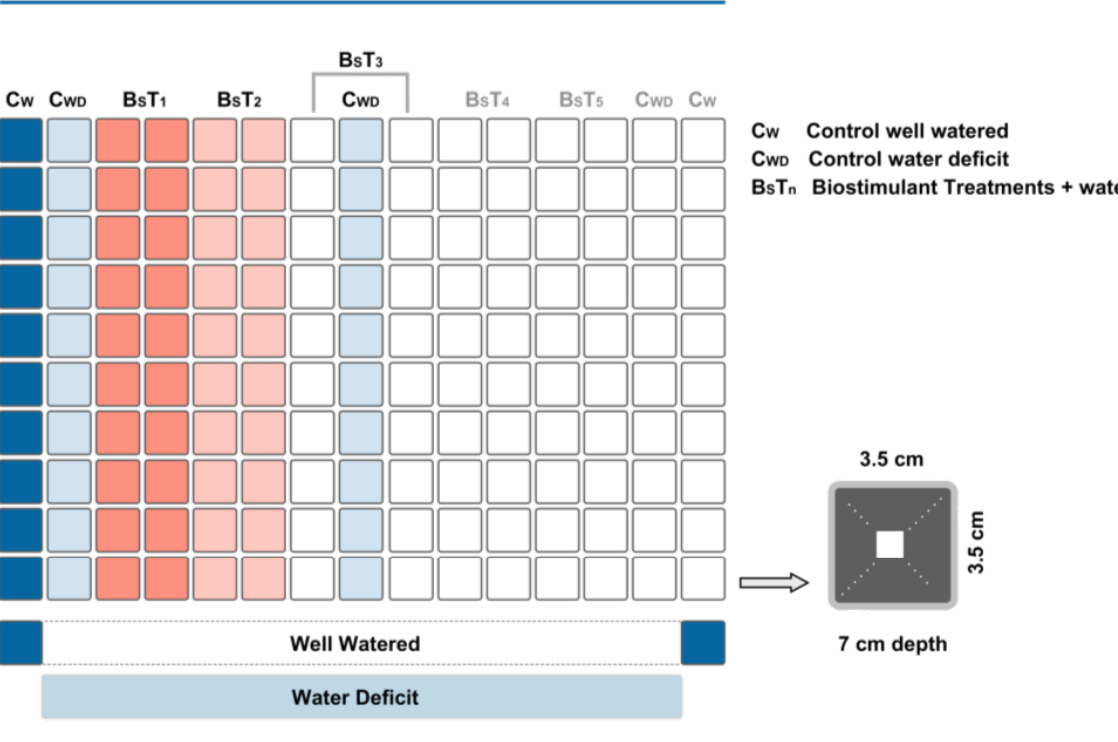
Figure 1. Experimental treatments distribution (20 seedlings per treatment) and cells dimensions of a 150-cell seedling tray.